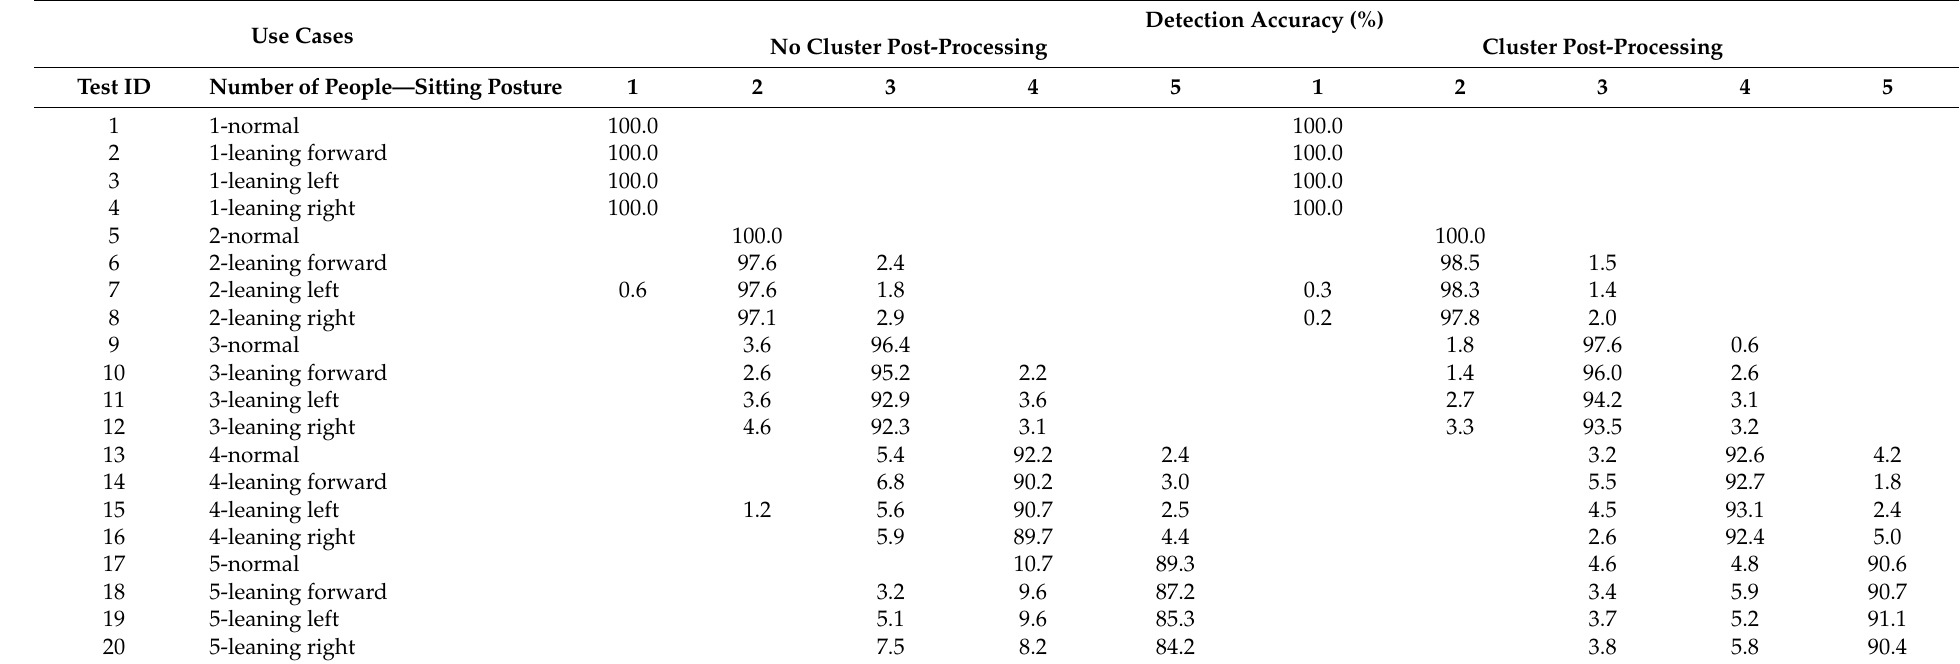
Table 4. Presentation detection results with or without clustering post-processing in static use